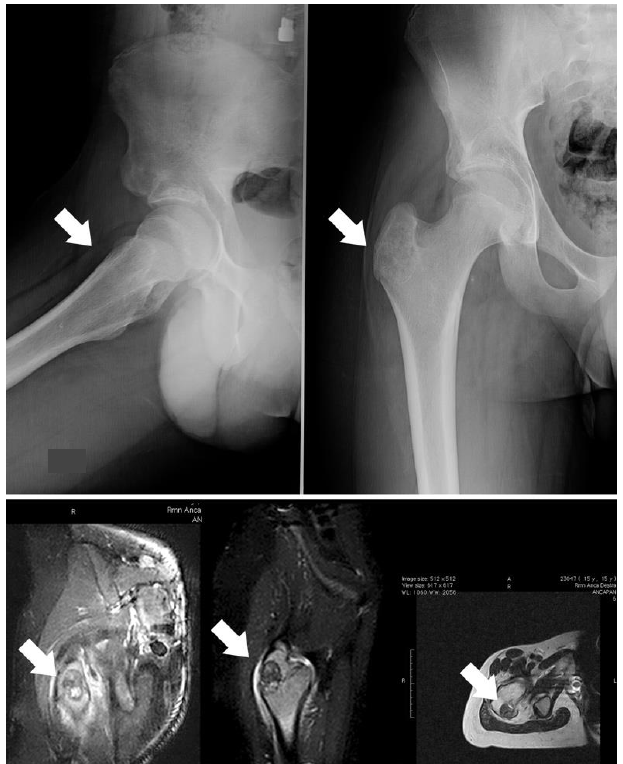
Figure 4. Case 3, a male patient with OBL of the right trochanter; on the upper image, the X-ray shows a quite well-defined osteolytic lesion (white arrows); on the lower image, the related MRI highlights the important oedema surrounding the OBL. The indication for surgery was based on the risk of a fracture due to both eventual RF thermoablation and the action of pelvic-trochanteric